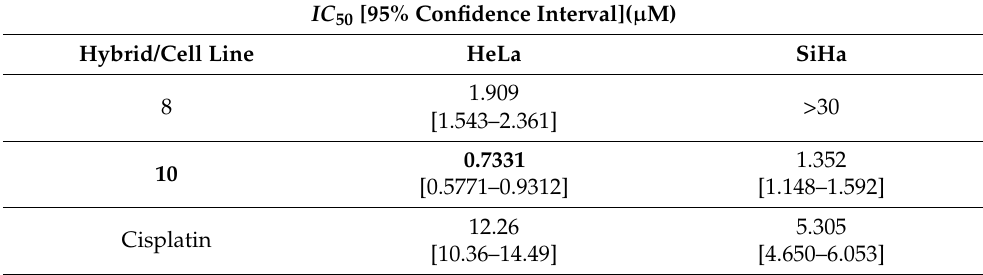
Table 2. In vitro antiproliferative activity of compounds 8 and 10 against human cervical cancer cell lines. Compounds were tested in the concentration range of 0.1–30 µ M in 2 biological replicates, 5 parallel measurements each. IC 50 values and their 95% confidence intervals (C.I.) are presented. Value where IC 50 < 1 µ M is highlighted in bold. Cisplatin was included as a reference agent. IC 50 [95% Confidence Interval]( µ M) Hybrid/Cell Line HeLa SiHa 8